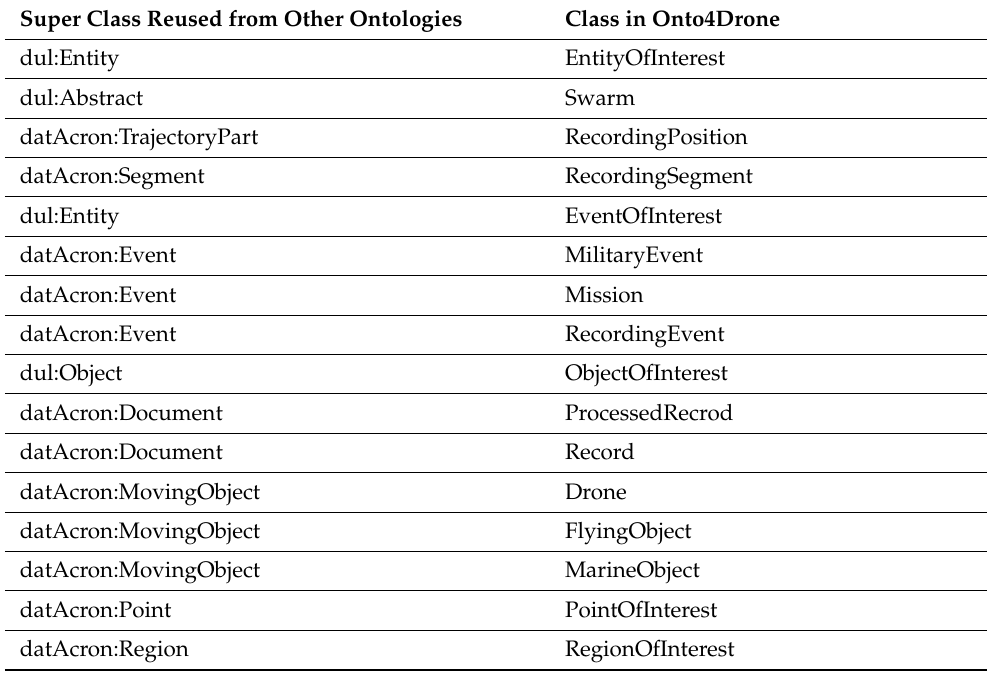
Table 1. Key classes of the Onto4drone